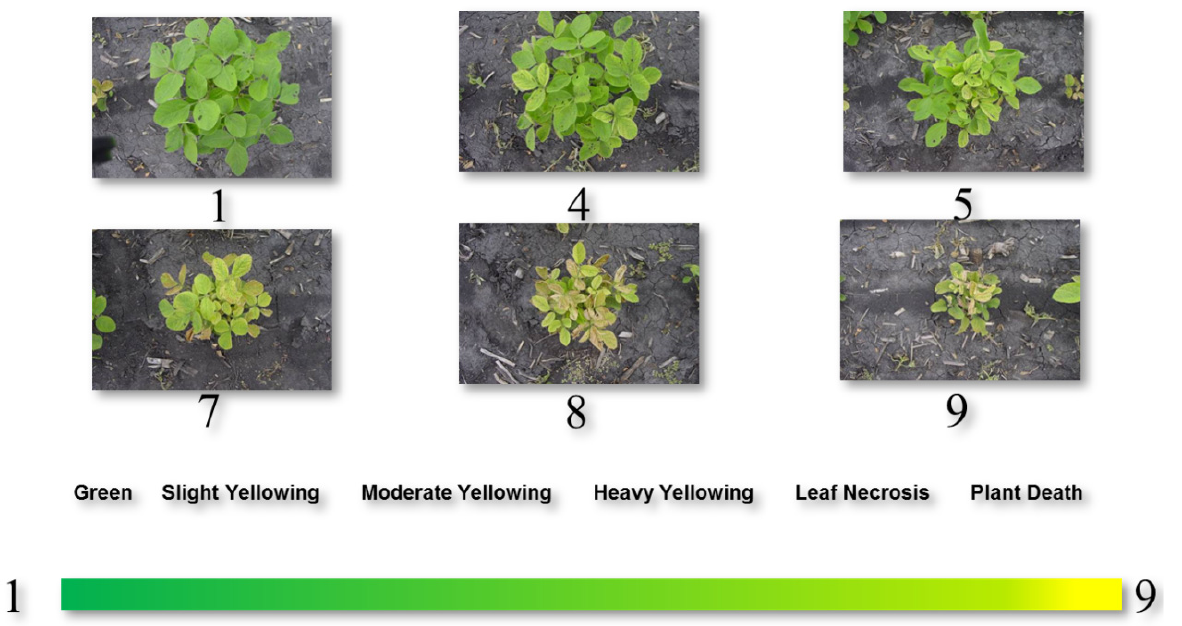
Figure 2. IDC score reference from 1 to 9 as ordinal data. 1 = green leaves (no chlorosis) to 9 = dead plant. Each image was taken from one hill plot with three to eight plants at growth stages V2 to V4. The IDC scores are visual scores by breeders.